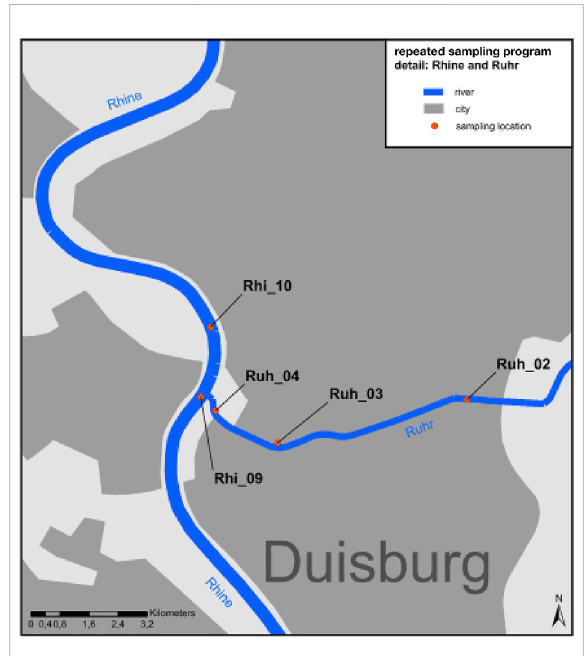
FIGURE 2 Repeated sampling program at two locations of the Rhine River (Rhi_09 upstream of the Ruhr River and Rhi_10 downstream of the Ruhr River) and one location at the mouth of the Ruhr River